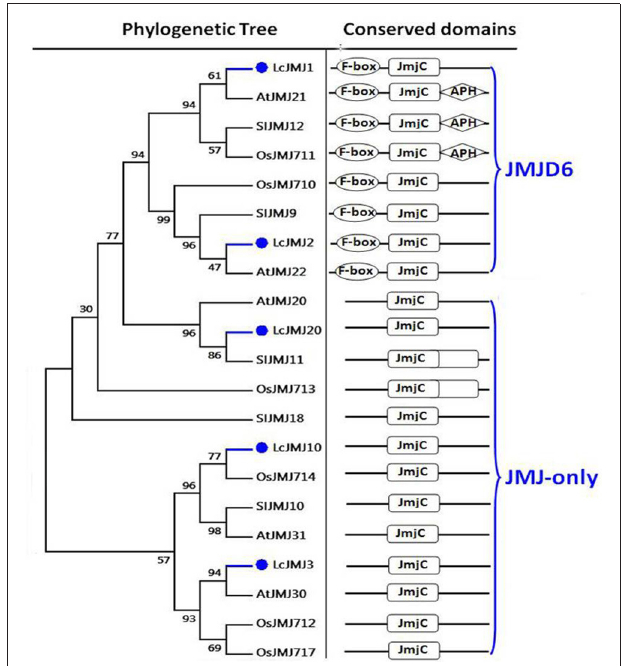
FIGURE 7 | Maximum likelihood phylogenetic trees and schematic diagrams for domain composition of JMJD6 class and JMJ-only class HDM proteins predicted from Litchi chinensis (Lc), Arabidopsis thaliana (At), Oryza sativa (Os), and Solanum lycopersicon (Sl). N-terminal F-box (PF00646), and C-terminal JmjC are conserved domains of JMJD6 class; JmjC domain is the conserved domain of the JMJs-only class demethylases. The phylogenetic tree was constructed based on the amino acids sequences with 1,000 bootstrapping